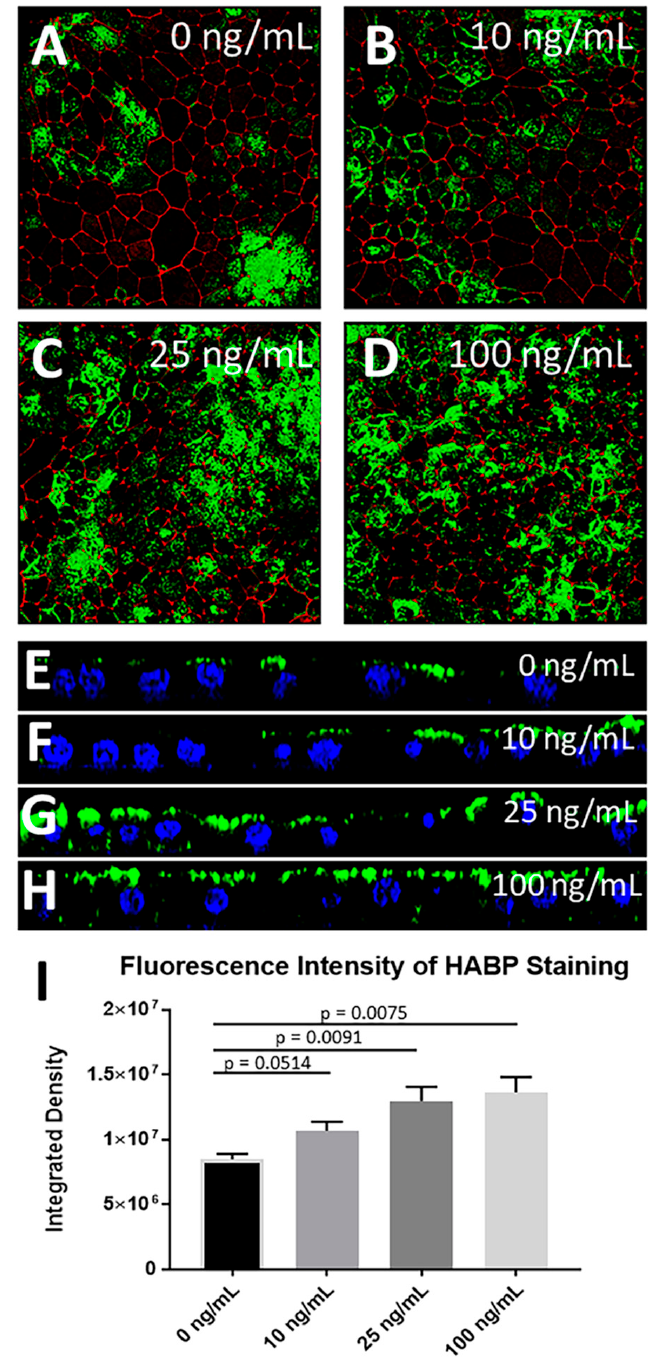
Figure 4. FGF-2 induces HA accumulation in primary RPE cells. ( A – D ) FGF-2 induced HA accumulation in primary porcine RPE cells in a dose-dependent manner ( A ) 0 ng / mL, ( B ) 10 ng / mL, ( C ) 25 ng / mL, ( D ) 100 ng / mL. Fluorescence intensity was quantitated by integrated density measurement ( I ) (n ≥ 4, for each cell line). Data are presented as mean ± SEM ( E – H ) Z-plane images show that increased concentrations of FGF-2 induce increased apical accumulation of HA in addition to some peri-cellular and basal deposits of HA at high doses of FGF-2. Green: HA, red: phalloidin; blue: DAPI. To determine if the accumulation of HA seen in RPE cells expressing S179C-TIMP3 was a consequence of increased FGF signaling, cells (RPE cells expressing S179C-TIMP3, wildtype TIMP3 or empty vector) were treated with BGJ-398, an FGF receptor inhibitor. 10 µ M BGJ-398 decreased